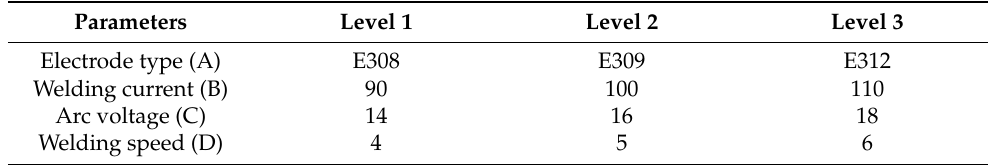
Table 2. Factors and levels for the welding